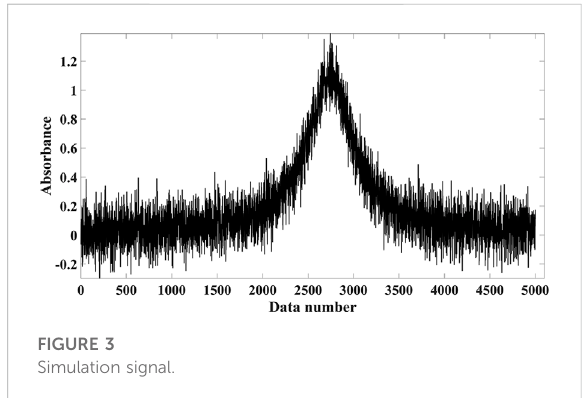
FIGURE 3 Simulation